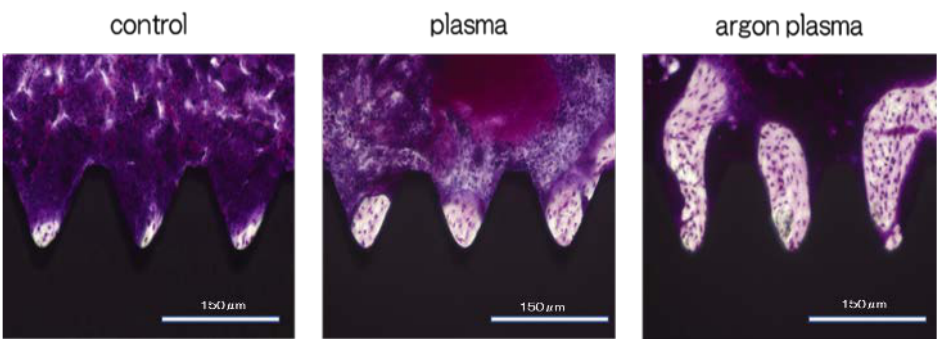
Figure 11. Furthermore, the amount of new bone formation was confirmed based on the longitudinal sections. Greater amount of newly formed bone was observed around the implants in the argon plasma-treated group, among all three groups. Black; implant body, purple; bone area.